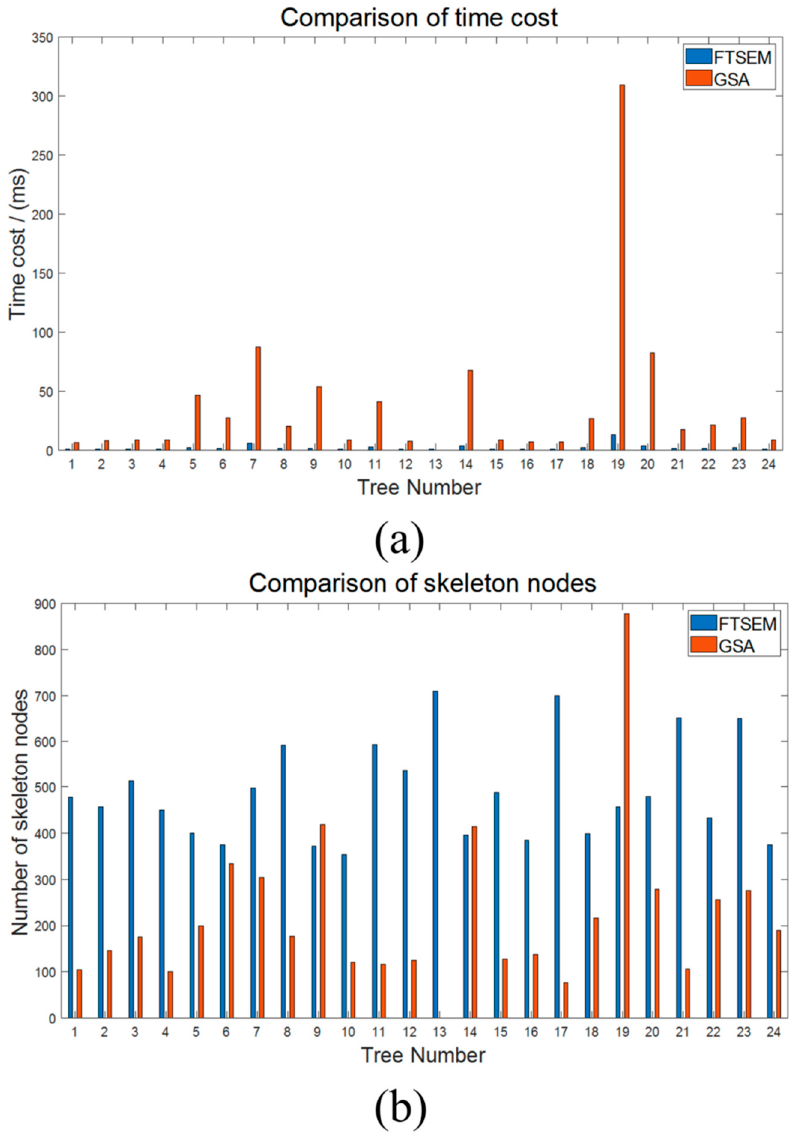
Figure 8. The node number and time cost comparison of FTSEM and GSA, ( a ) the comparison information of time cost, ( b ) the comparison information of node number.